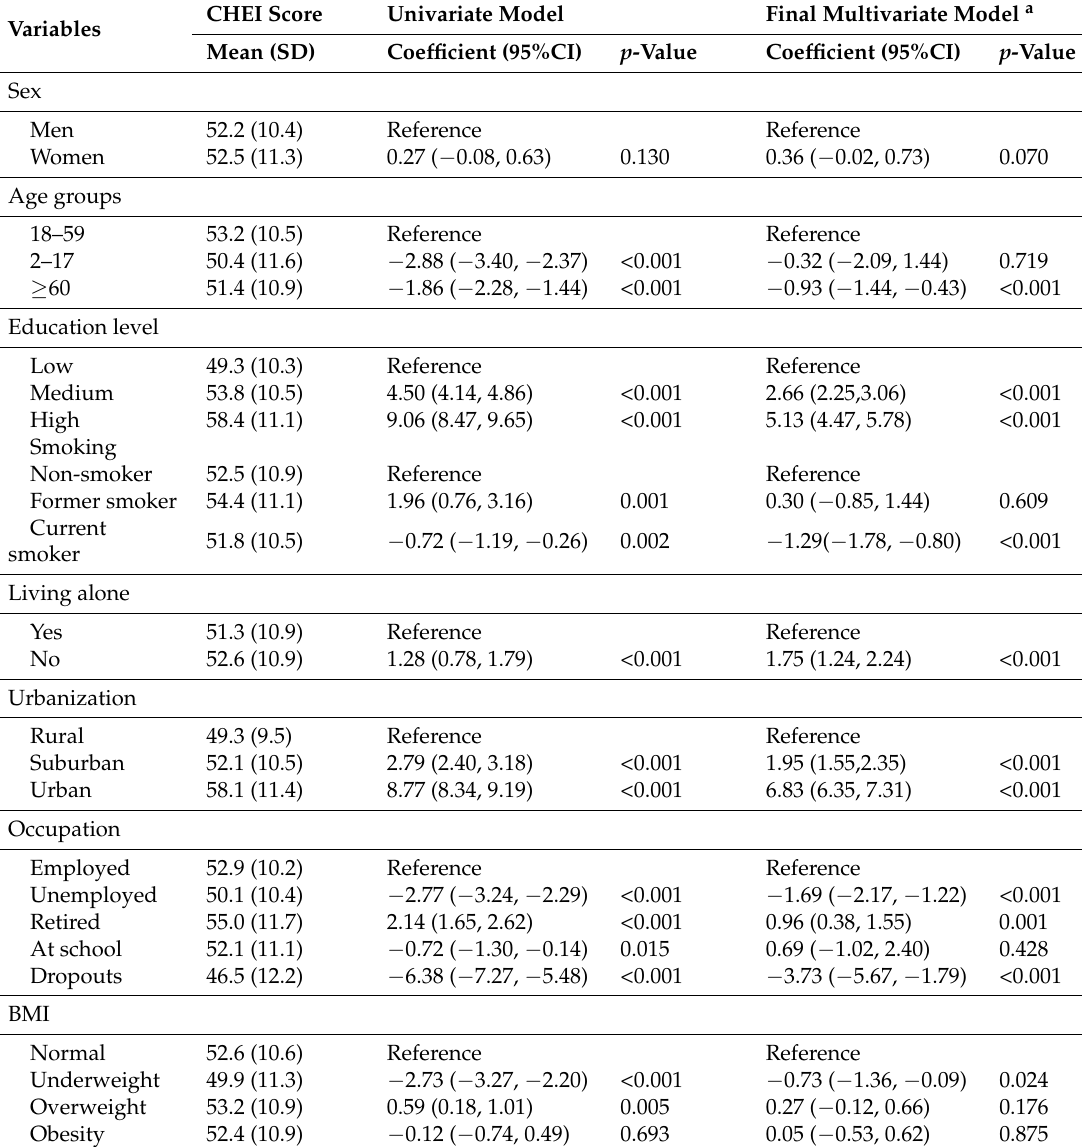
Table 6. Linear regression models for total CHEI, classified by associated